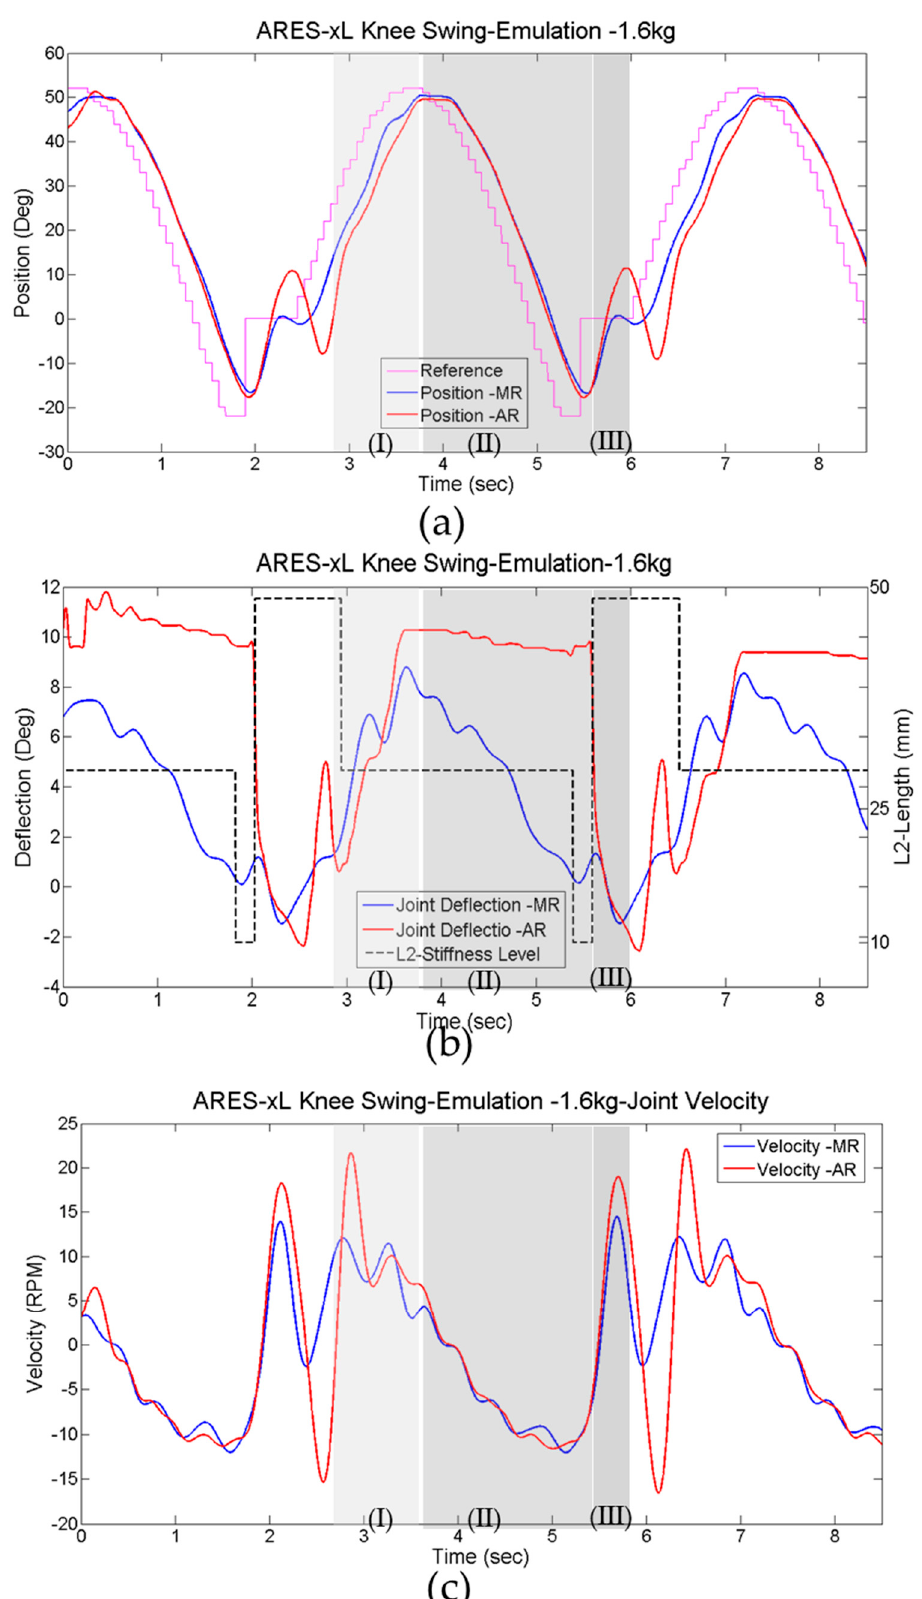
Figure 12. Knee-swing emulation: ( a ) the ARES-XL joint position and trajectory; ( b ) the ARES-XL velocity; and ( c ) the ARES-XL deflection and stiffness levels state machine.